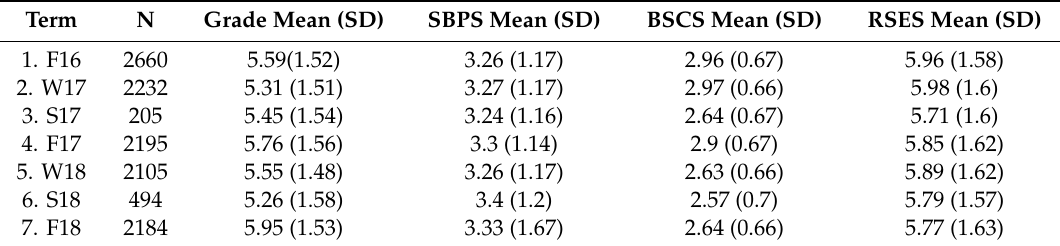
Table 2. Descriptive Statistics.